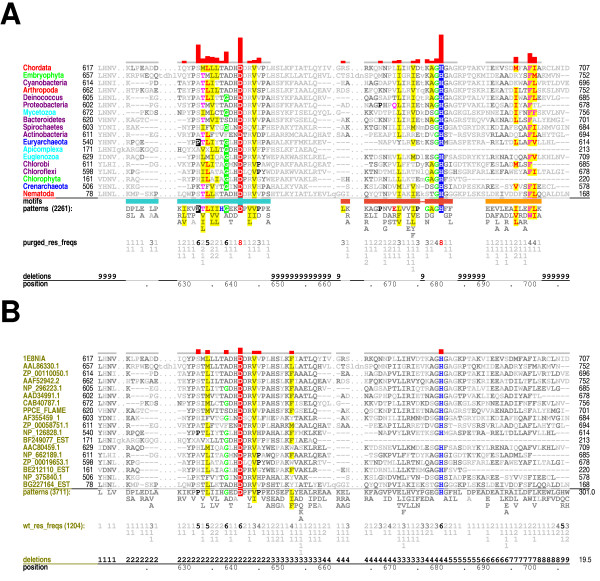
CHAIN analysis of α,β-hydrolase fold constraints acting on prolyl oligopeptidases. See legend to Fig. 4 for descriptions. (A) Motif-based contrast hierarchical alignment. The bars directly below the displayed sequences indicate motifs with the narrow line indicating a deletion relative to that motif and wide bars indicating catalytic residues. (B) PSI-BLAST generated contrast hierarchical alignment. The histogram heights for the catalytic aspartate and histidine in this alignment are shorter in this figure because, unlike the motif-based alignment in (A), the PSI-BLAST algorithm assigns relatively stronger constraints to the nucleophilic catalytic residue (not shown) that is much easier to align correctly.